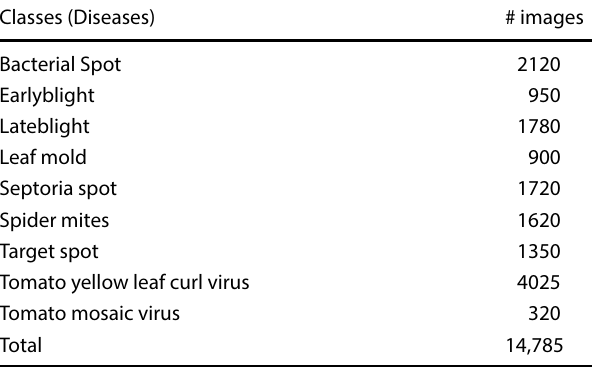
Table 1 Dataset